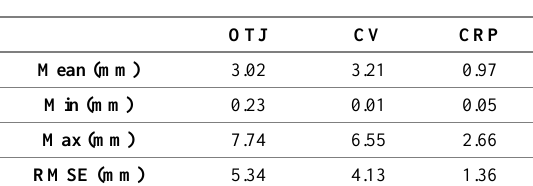
Table 6: Distance error on Check_Field_1 .